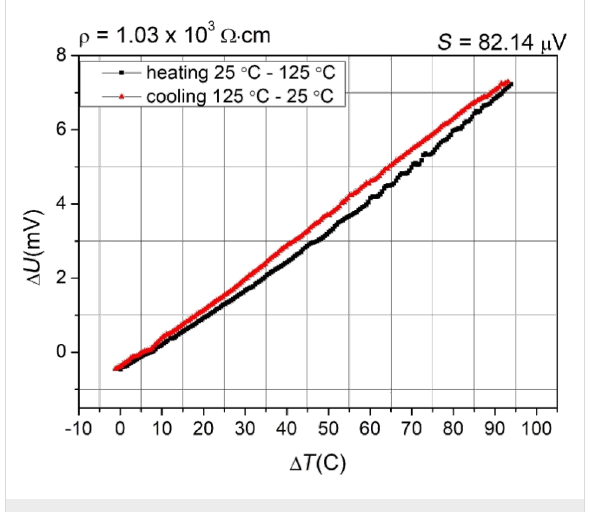
Figure 1: Characteristics of the thermoelectrical voltage of a (Ti–Cu)Ox thin film.